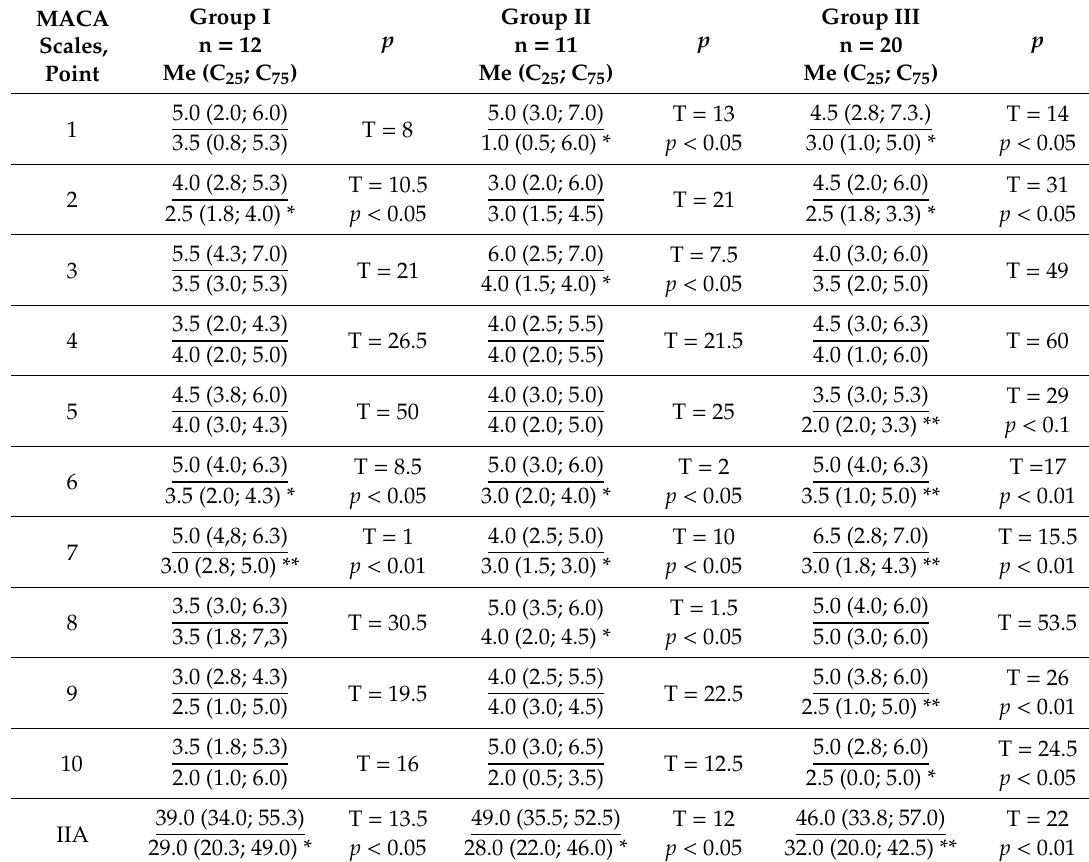
Table 1. Anxiety indices in younger schoolchildren before and after the therapy sessions, (Me, 25; 75